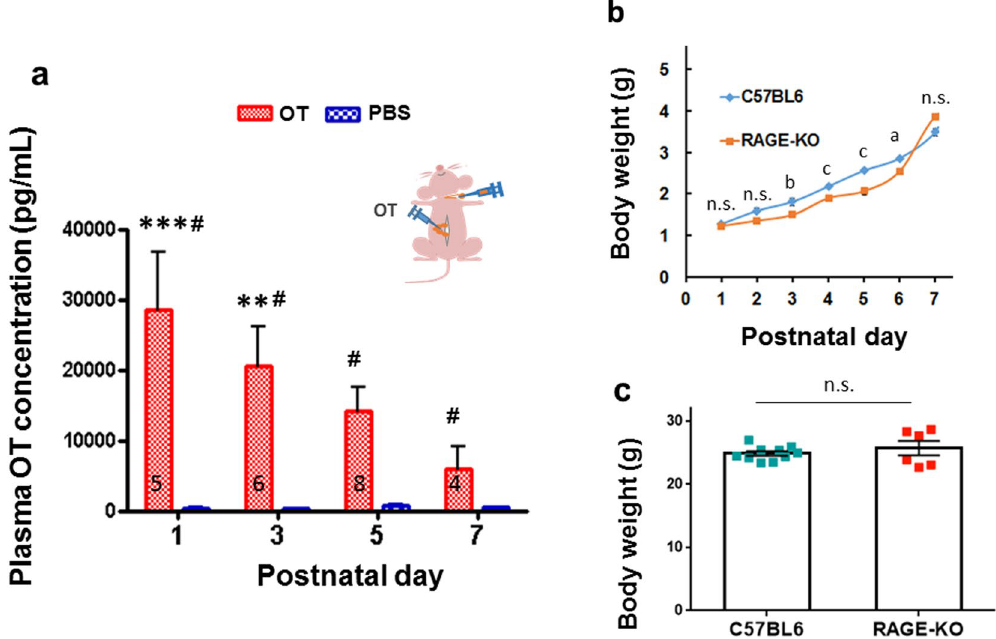
Figure 2. Plasma OT levels in pups after intestinal delivery of OT. ( a ) Blood samples were collected from the carotid artery after cutting the neck of male and female pups at PND1, 3, 5, and 7, 10 min after the administration of OT (Red; 100 μ M × 5 μ L, 0.5 μ g/mouse) or the same volume of PBS (Blue) into the upper small intestinal tract (inset). Two-way ANOVA, F 3,40 = 3.14, P < 0.05. Bonferroni’s post hoc tests showed significant differences between OT and saline ( # P < 0.001); OT and PNDs, *** P < 0.001, ** P < 0.01 from values at PND7. The number of experiments is shown. ( b ) Weight curve during the 7 days after birth for wild-type (blue diamonds, n = 104) and Ager − / − (RAGE KO; orange squares, n = 78) male and female pups. A two-way ANOVA revealed significant differences between body weights of wild-type and KO mice for Genotypes ( F 1,6 = 11.81 P < 0.007), PNDs ( F 1,6 = 142.95, P < 0.0001) and interaction between Genotypes x PNDs ( F 2,278 = 5.10, P < 0.0001). Bonferroni’s post hoc tests showed 0.493 (not significant (n.s.)), 0.154 (n.s.), 0.003 (b), 0.00005 (c), 0.00002 (c), 0.002 (a), 0.057 (n.s.) for P values at PND1-7, respectively. ( c ) Body weights of adult males of 11 week-old mice (n = 10 and 6 for wild-type and RAGE KO mice, respectively); Two-tailed Student t -test, P = 0.395, not